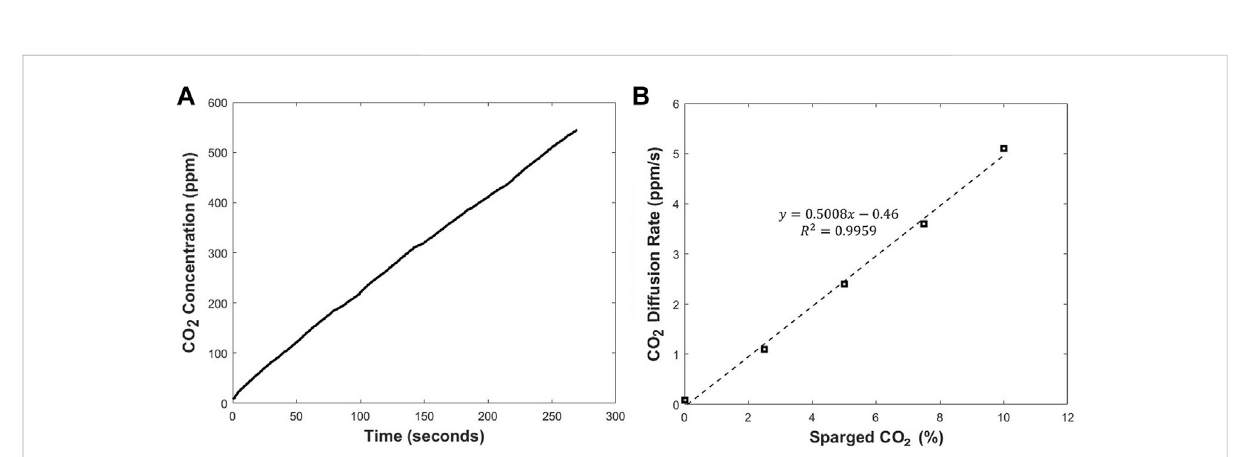
The CO 2 concentration pro fi le during a single recirculation period (A) and the relationship between the slope of CO 2 concentration pro fi le and the CO 2 level in cell culture medium (B)